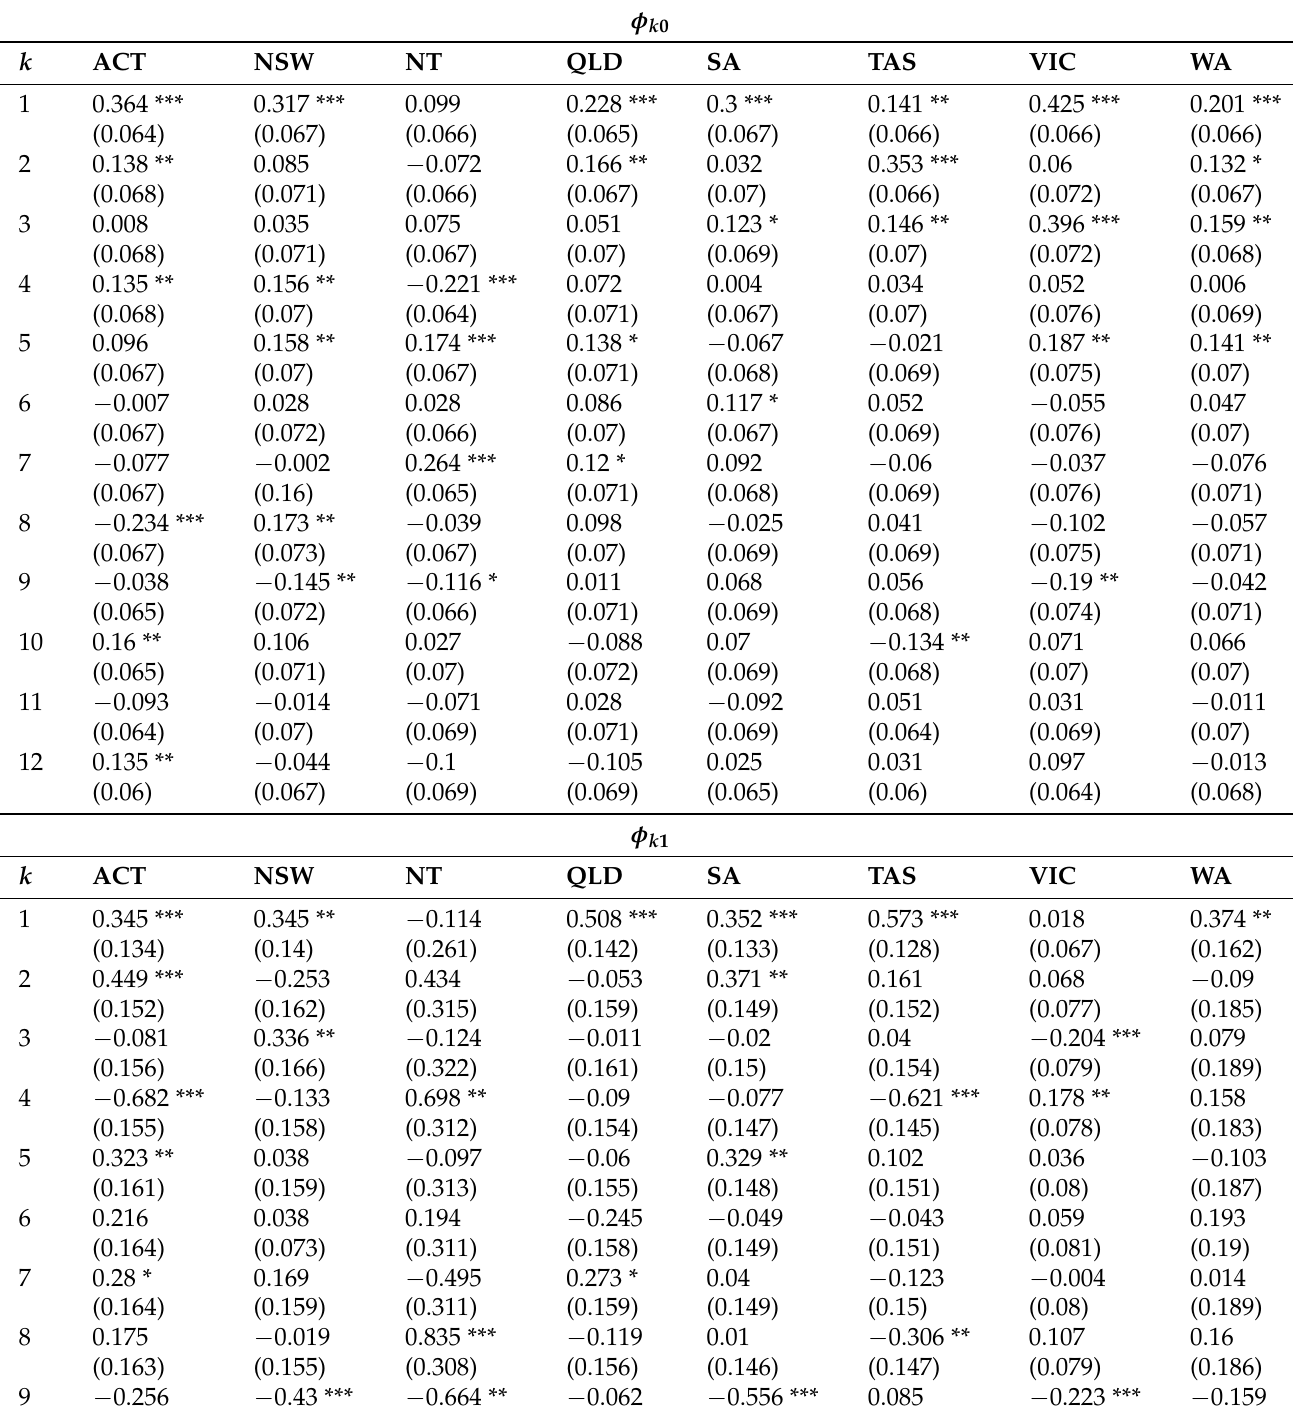
Table 4. Feasible GLS estimates of parameters and standard errors (in parentheses) of the fitted GSTARX(12; 1 ;(4,4,4,4,4,4,5,5,5)). p -values less than 0.01, 0.05 and 0.1 are indicated by three, two and one asterisk(s),